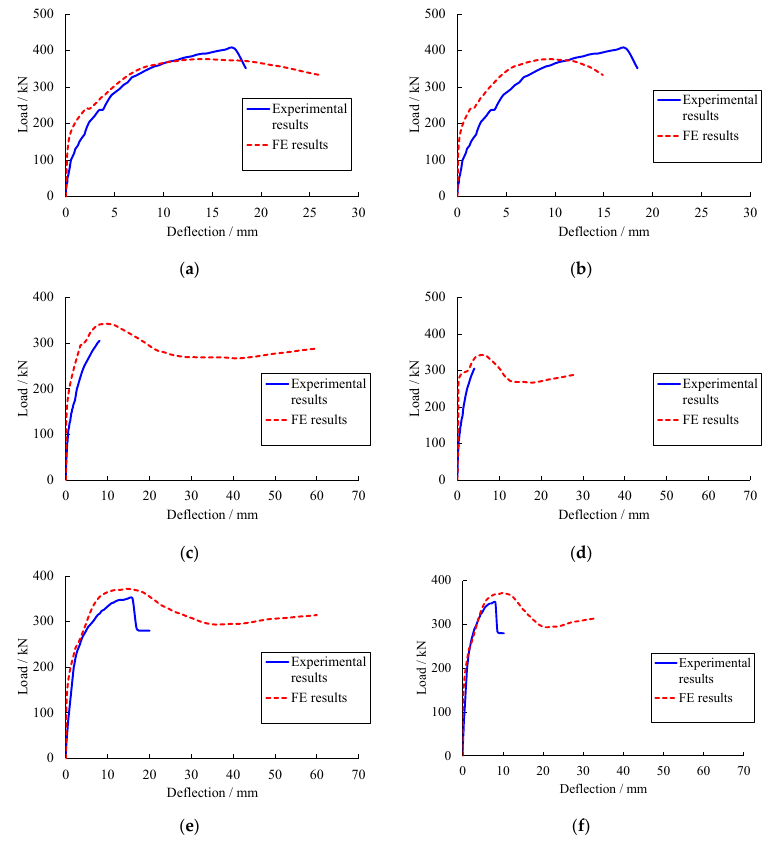
Figure 15. Comparison of load–deflection curves. ( a ) l /2 position of WS beam; ( b ) l /4 position of WS beam; ( c ) l /2 position of DSS1 beam; ( d ) l /4 position of DSS1 beam; ( e ) l /2 position of ZSS1 beam; ( f ) l /4 position of ZSS1 beam.